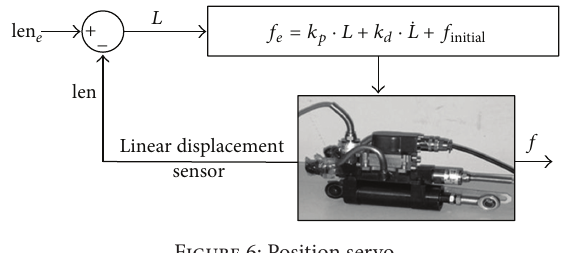
Figure 6: Position servo.